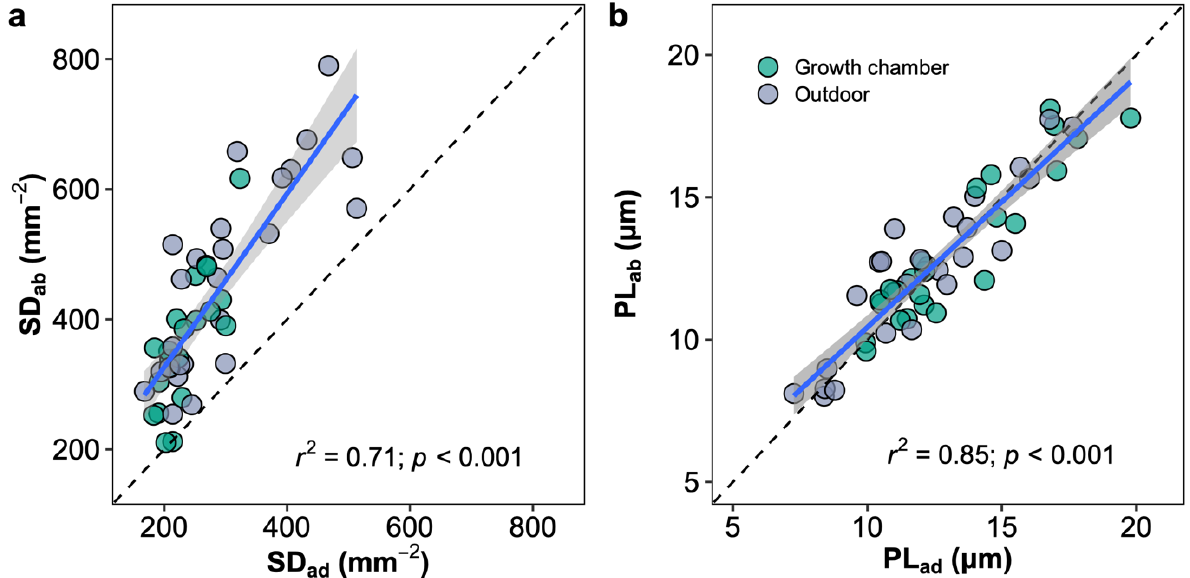
Figure 7. Correlations of stomatal density (SD; a ) and pore length (PL; b ) between adaxial (ad) and abaxial (ab) surfaces. Blue line represents the linear regression line; black dot line represents the 1:1 line; and the grey shaded area corresponds to the 95% confidence region of the regression line.